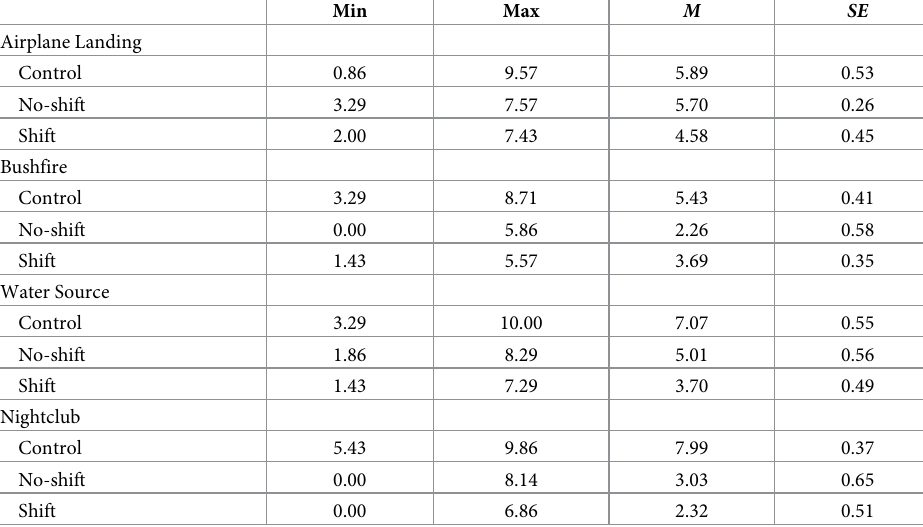
Table 2. Descriptive statistics for inference scores across scenarios and